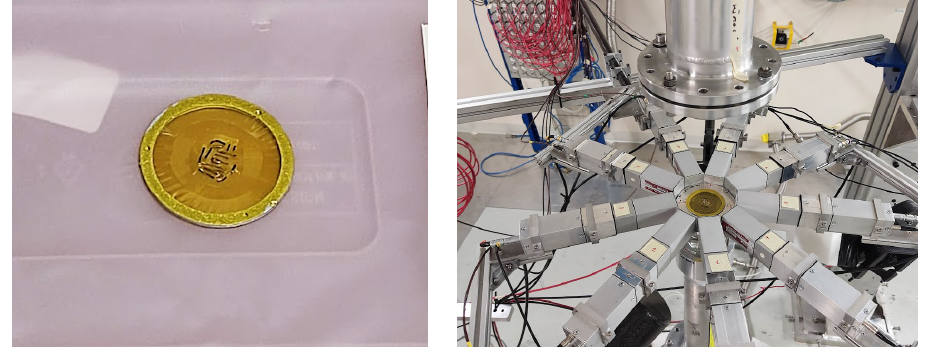
Figure 1. Left panel: Picture of the 94 Nb sample manufactured at PSI. Right panel: Picture of the experimental setup used during the experimental campaign at the n_TOF facility in April